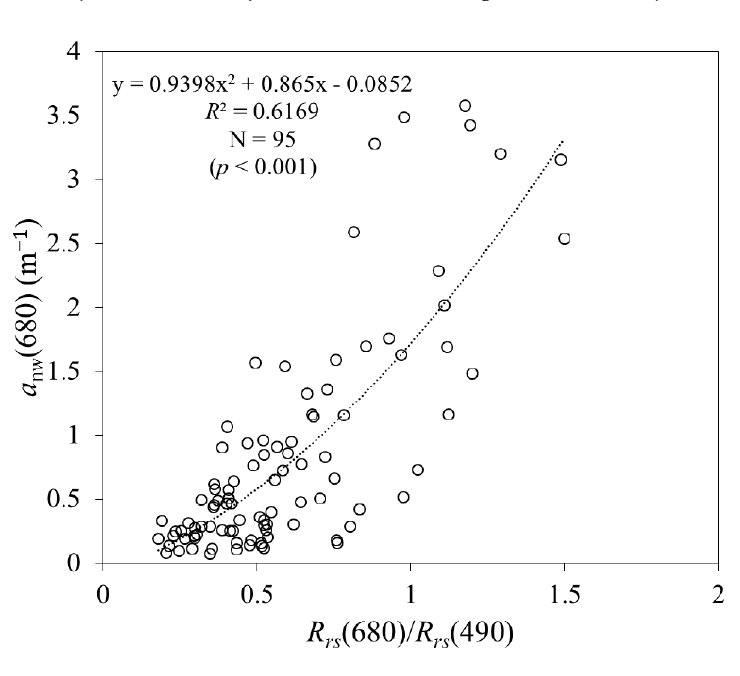
Figure 5. Scatter plot of in situ a p (443) values plotted versus b bp (680) values.